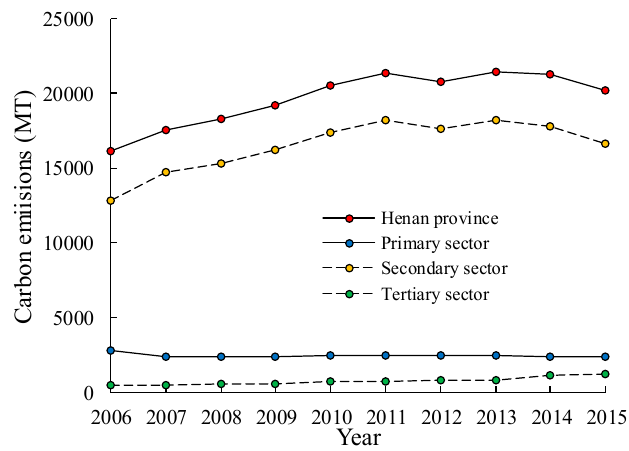
Figure 2. Variation of carbon emissions over time from three major economic sectors in Henan Province during 2006–2015. Int. J. Environ. Res. Public Health 2018 , 15 , x